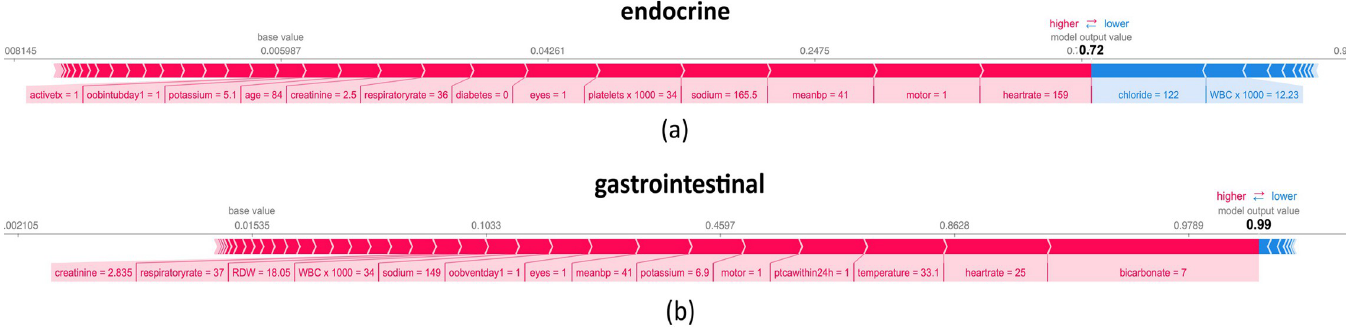
Fig 4. A detailed explanation of patient features with the highest mortality probability in endocrine and gastrointestinal disease groups using Shapley values (force plots).